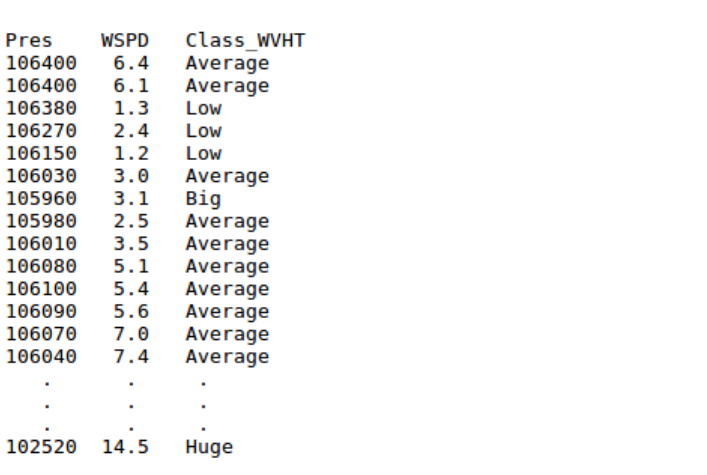
Figure 10. An example of the creation a Classification dataset, with a prediction horizon of 6 h and without synchronisation.